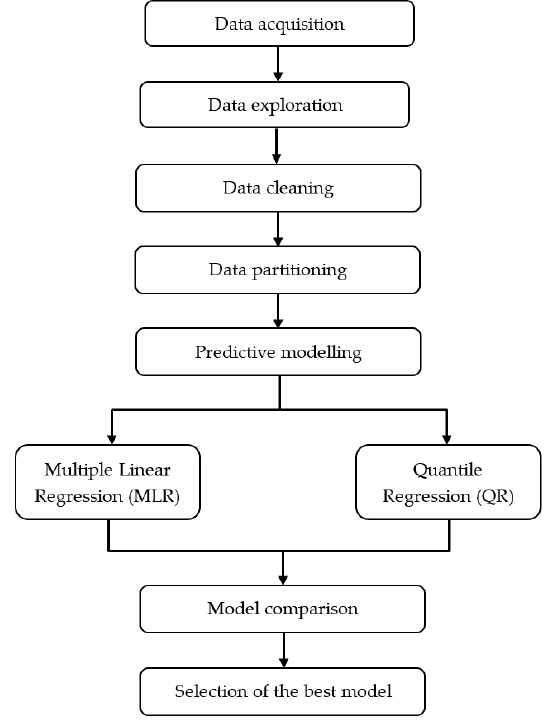
Figure 1. Modeling framework.